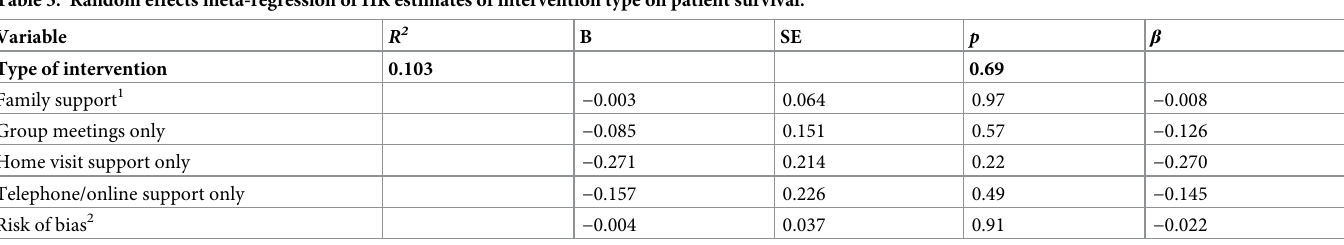
Table 3. Random effects meta-regression of HR estimates of intervention type on patient survival.